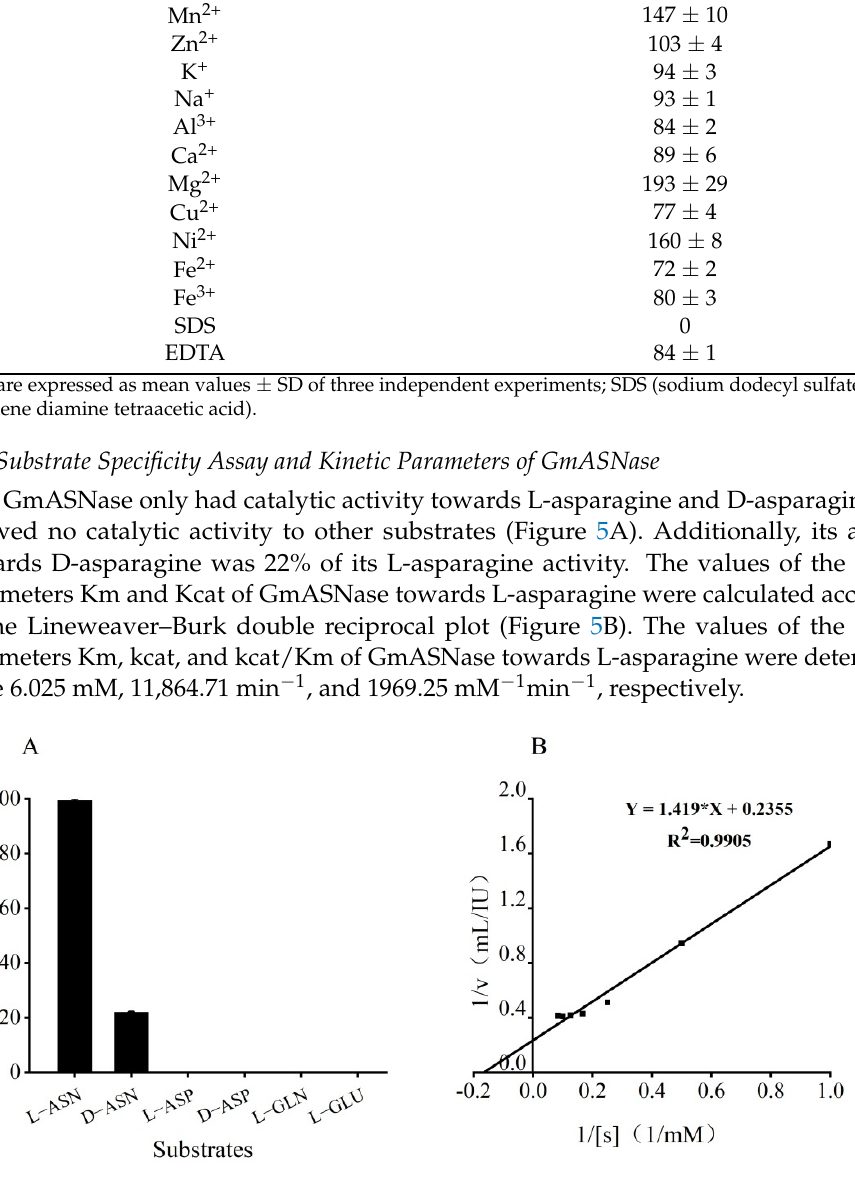
Figure 5. Substrate specificity assay ( A ) and kinetic parameters ( B ) of GmASNase. Data are expressed as mean values ± pressed as mean values ± SD of three independent experiments; L-ASN (L-asparagine); D-ASN SD of three independent experiments; L-ASN (L-asparagine); D-ASN (D-asparagine); L-ASP (L-aspartic acid); D-ASP (D- (D-asparagine); L-ASP (L-aspartic acid); D-ASP (D-aspartic acid); L-GLN (L-glutamine); L-GLU aspartic acid); L-GLN (L-glutamine); L-GLU (L-glutamic acid). (L-glutamic